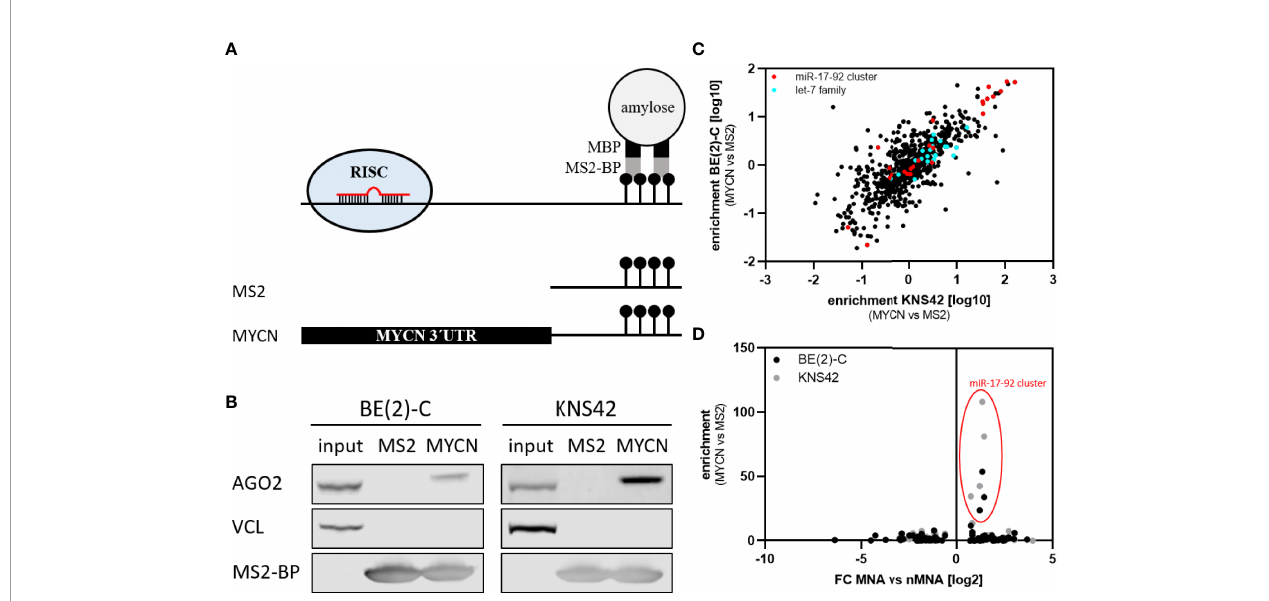
FIGURE 2 | miTRAP identi fi ed selective co-puri fi ed miRNAs with in vitro transcribed bait RNA. (A) Scheme of the miTRAP procedure. In vitro transcribed bait RNAs comprising two MS2 stem-loops fused to the 3´ end of bait transcripts were immobilized on amylose resin (light gray) via recombinant MBP-fused (black) MS2-BP (dark gray) protein (upper panel). Scheme of the used bait RNAs (lower panel). MS2: 120-nt-long control RNA encoded by the template vector, MYCN: wild type 3´ UTR of the MYCN mRNA. (B) Western blot analysis of indicated proteins isolated from BE(2)-C and KNS42 cells co-puri fi ed with MS2 control transcript (MS2) or the MS2-fused MYCN 3´UTR (MYCN), respectively. Vinculin (VCL) served as negative control for unspeci fi c binding, whereas MS2-BP indicates equal loading of the resin. (C) Enrichment of speci fi c miRNAs was calculated as ratio of MYCN 3´UTR compared to MS2 control pulldown. Enrichment from BE(2)-C and KNS42 cells show strong consistency in enriched miRNAs (Pearson correlation: R P = 0.7784, p < 0.0001). The miR-17-92 cluster is depicted in red, the let-7 family in cyan. (D) The enrichment of miRNAs with the MYCN-3 ’ UTR in BE(2)-C and KNS42 cell lines were compared to the fold change of miRNA expression in MNA versus nMNA tumors. Only members of the miR-17-92 cluster are consistently and substantially enriched at the MYCN 3´UTR and upregulated in MNA